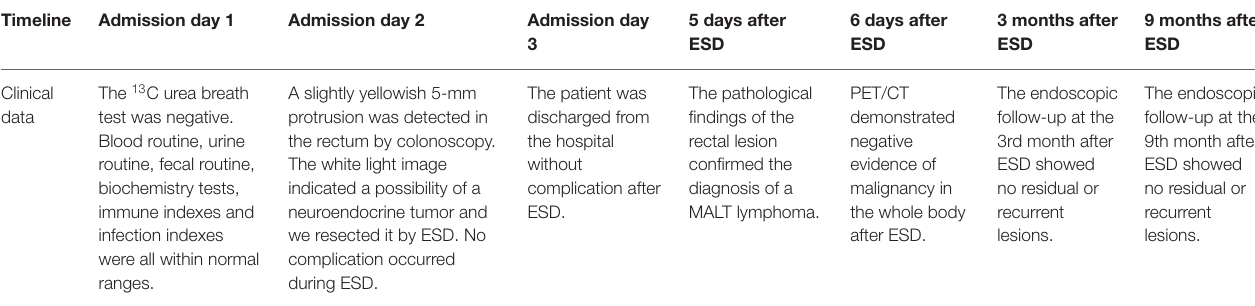
TABLE 1 | The timeline with relevant data from the episode of care. Timeline